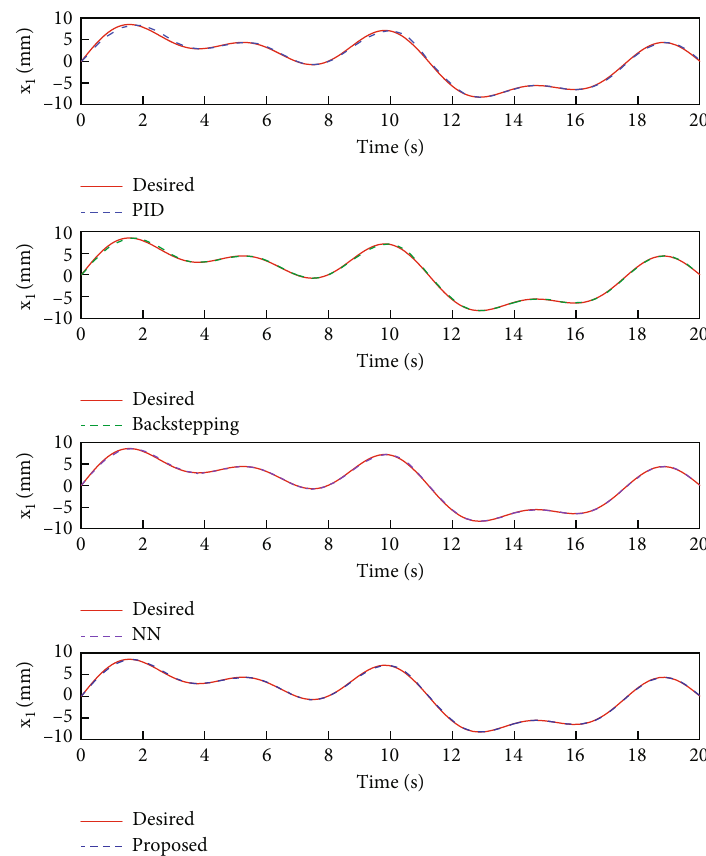
Figure 13: Tracking performance of multifrequency sine